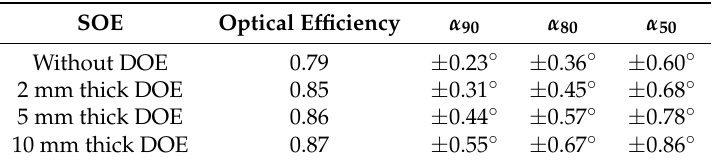
Table 1. Optical efficiency (normal incidence) for the different optical designs presented. α 90 , α 80 , and α 50 are the light incidence angles corresponding to 90%, 80%, and 50% of the maximum optical efficiency. SOE: secondary optical element. SOE Optical Efficiency α 90 α 80 α